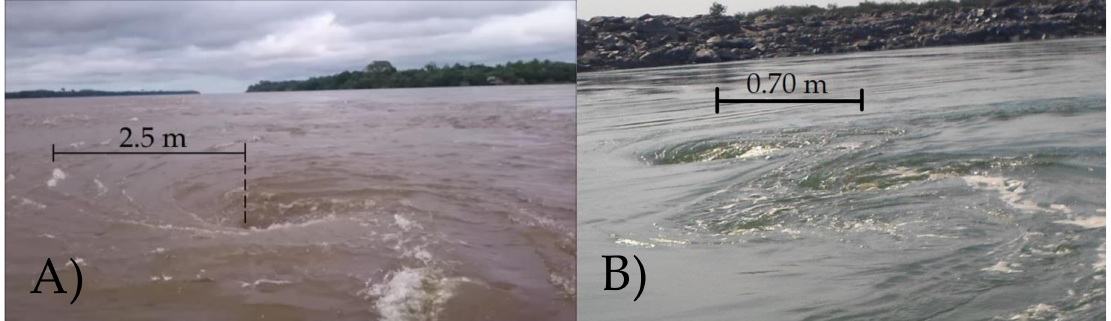
Figure 3. Large vortices in the canyon shear-layer where steep bathymetrical gradients exist; ( A )